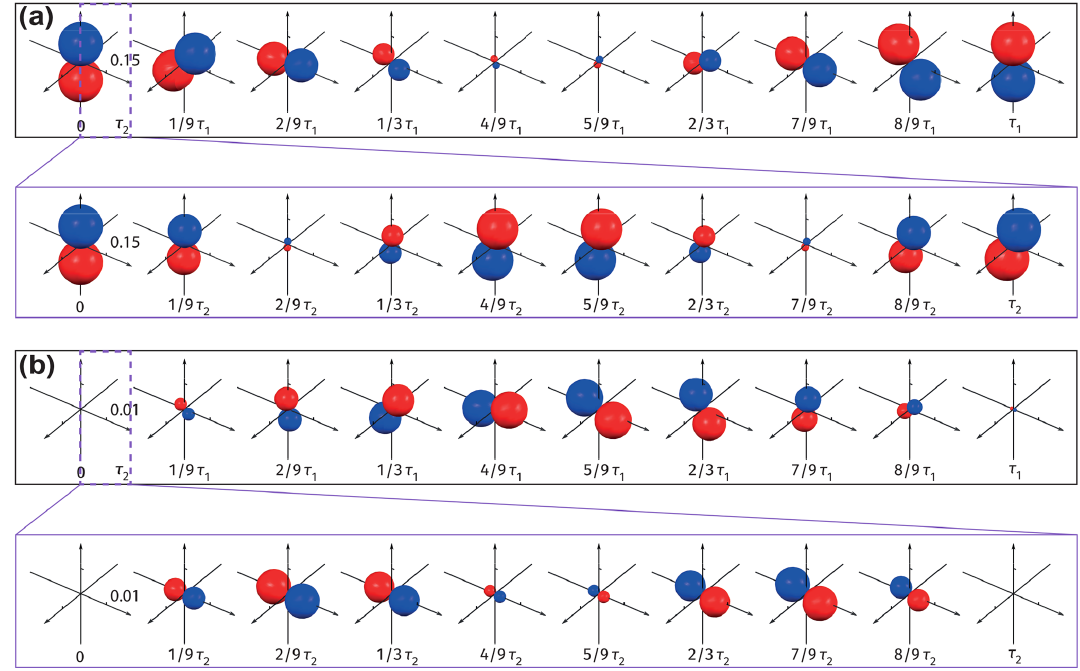
Figure 6. Visualizations of spin dynamics in an AX system ( 1 H– 13 C nuclear pair) during the ZULF experiment. Conditions used for simulation are the same as that used in Fig. 5 except for assuming an initial density operator of (a) ˆ ρ 0 = (3 / 20)( ˆ I 2 z − ˆ I 1 z ) and (b) ˆ ρ 0 = 1 1 + 1 ( ˆ I 2 z + ˆ I 1 z ). Surfaces in panels (a) and (b) are plotted with the measurement operator 4 4 panels (a) and (b) show the evolution of the surfaces over a shorter timescale τ 2 . Note the different scaling in panels (a) and (b)